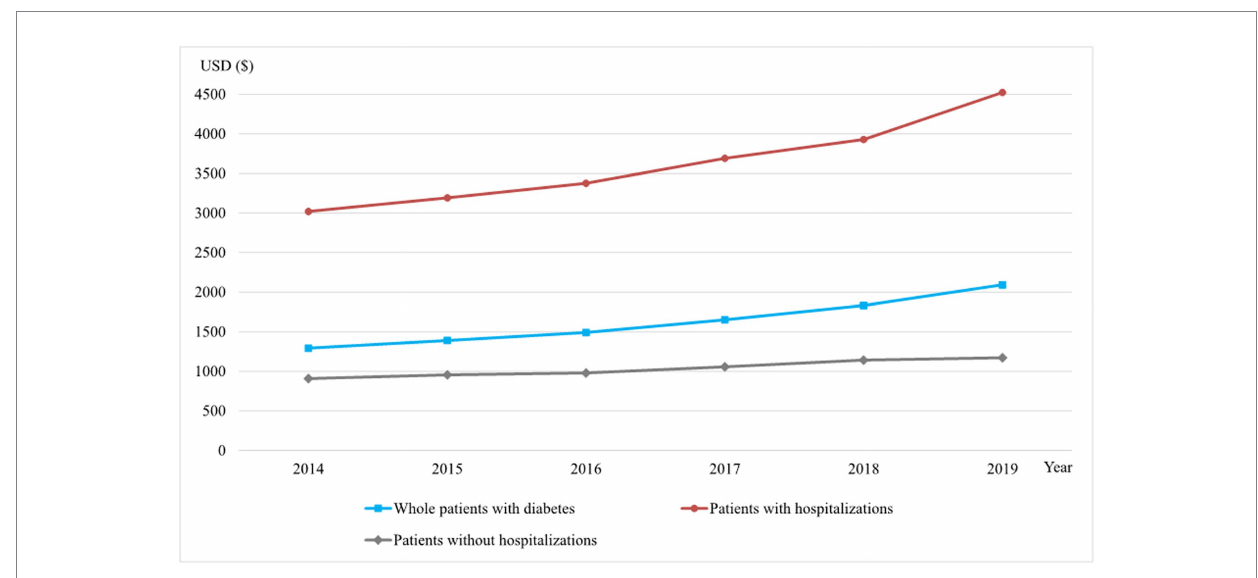
FIGURE 1 The average annual DM costs of diabetic patients with different hospitalization status, 2014–2019